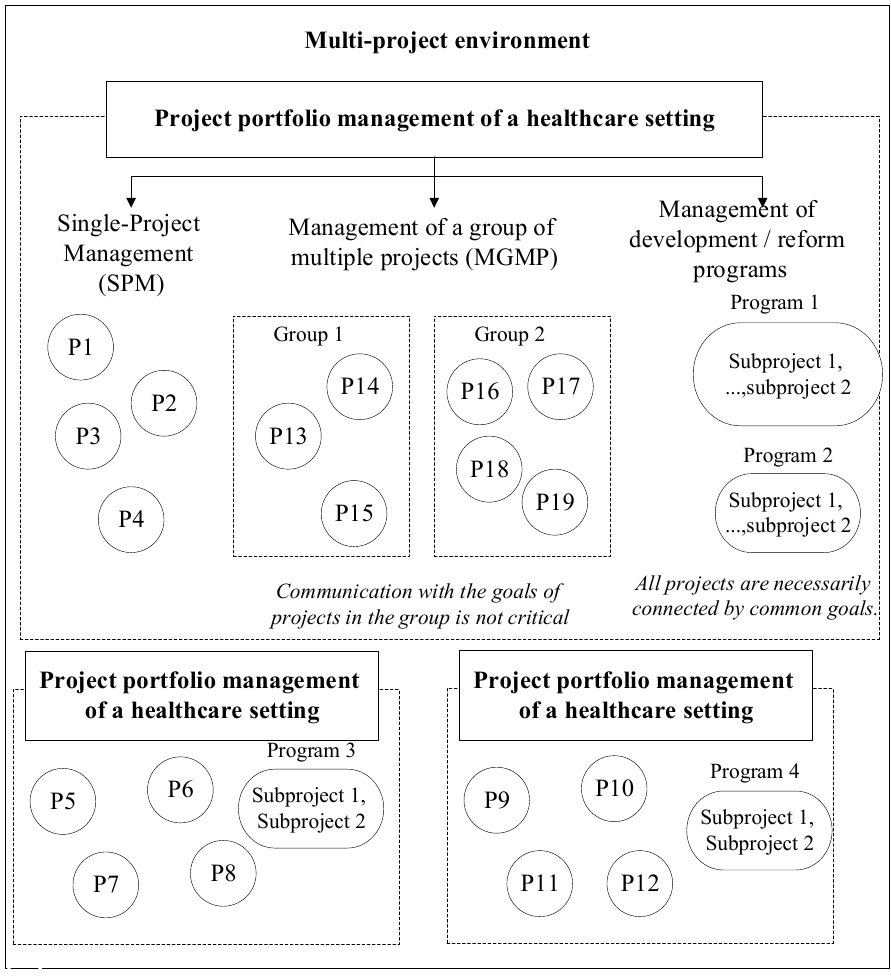
Figure 2. Multi-project environment of healthcare settings.